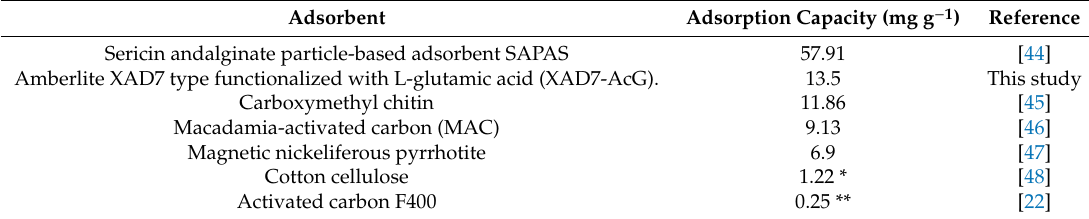
Table 2. Maximum adsorption capacities of previously studied adsorbents.